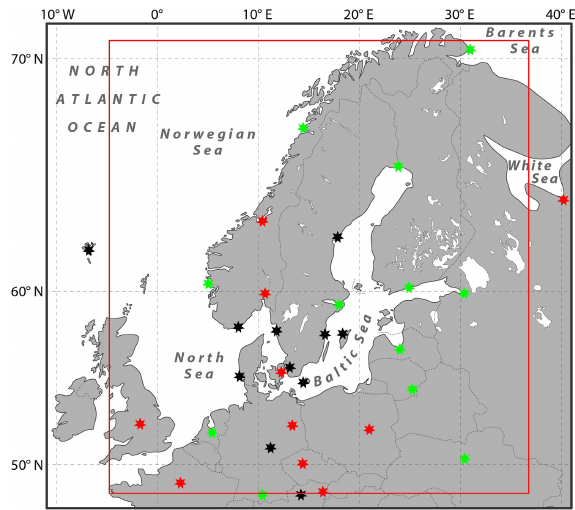
Fig. 2. Geographic positions of stations used as predictor in this study. Green stations provide daily SLP and monthly T2M, black stations only daily SLP and red stations only monthly T2M. The domain of the reconstruction is indicated by the red